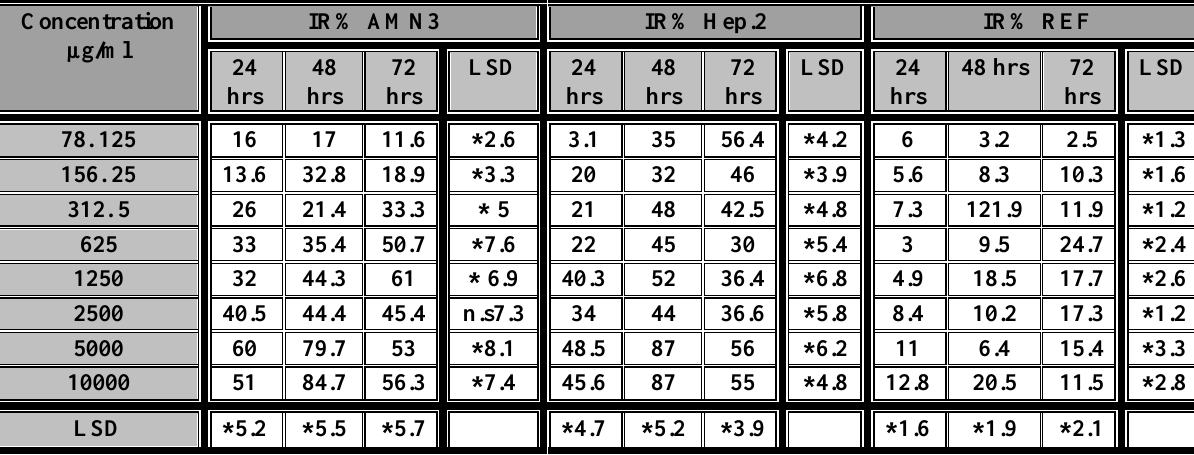
Table (1): Mean values of inhibition rate (IR%) of (AMN3, Hep.2 and REF )cell lines after treatment with different concentrations of ethanolic extract of Sonchus oleraceus for (24, 48 & 72) hours.